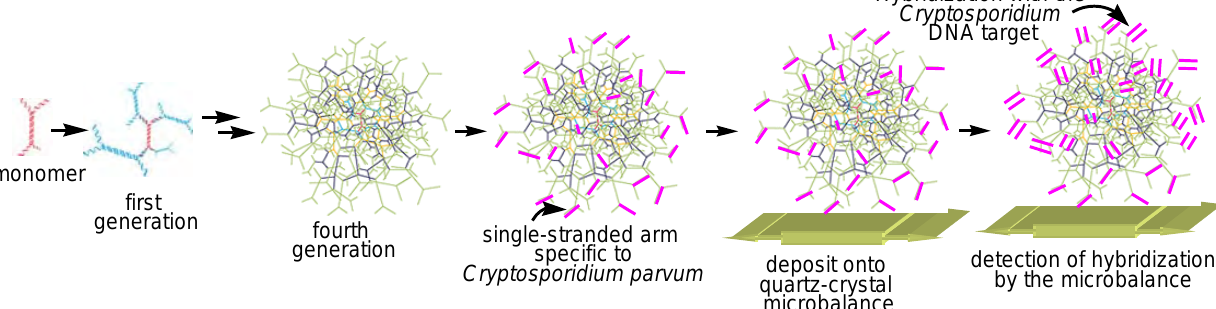
Figure 11. Synthesis of DNA dendrimers by selective hybridizations up to the fourth generation, and functionalization of end groups by specific single-stranded arms. Deposit onto quartz-crystal (only